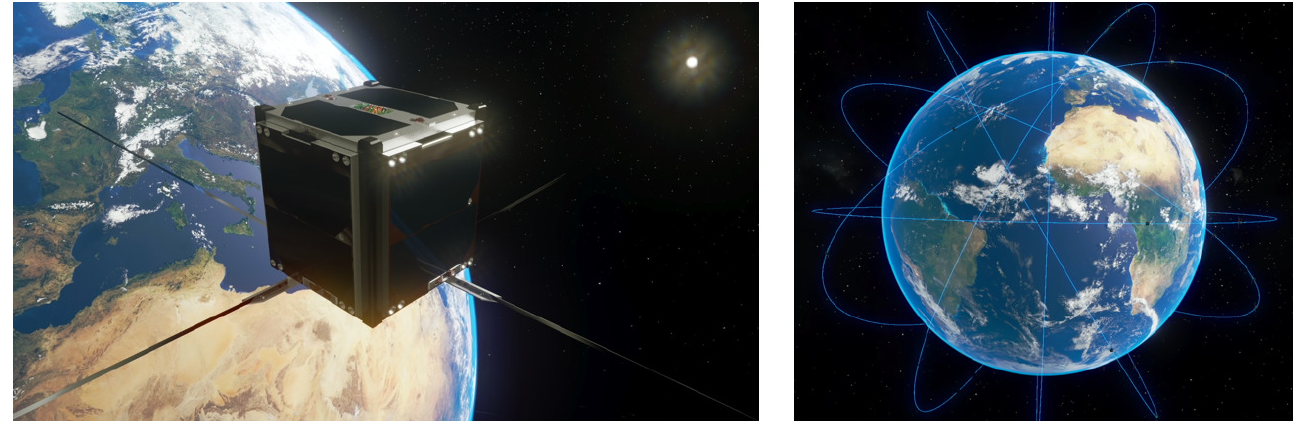
Figure 16. UVSQ-SAT and its potential future satellites constellation named